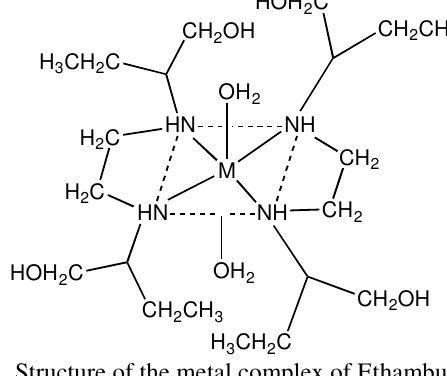
Figure 2. Structure of the metal complex of Ethambutol M = Cu [II] or Ni